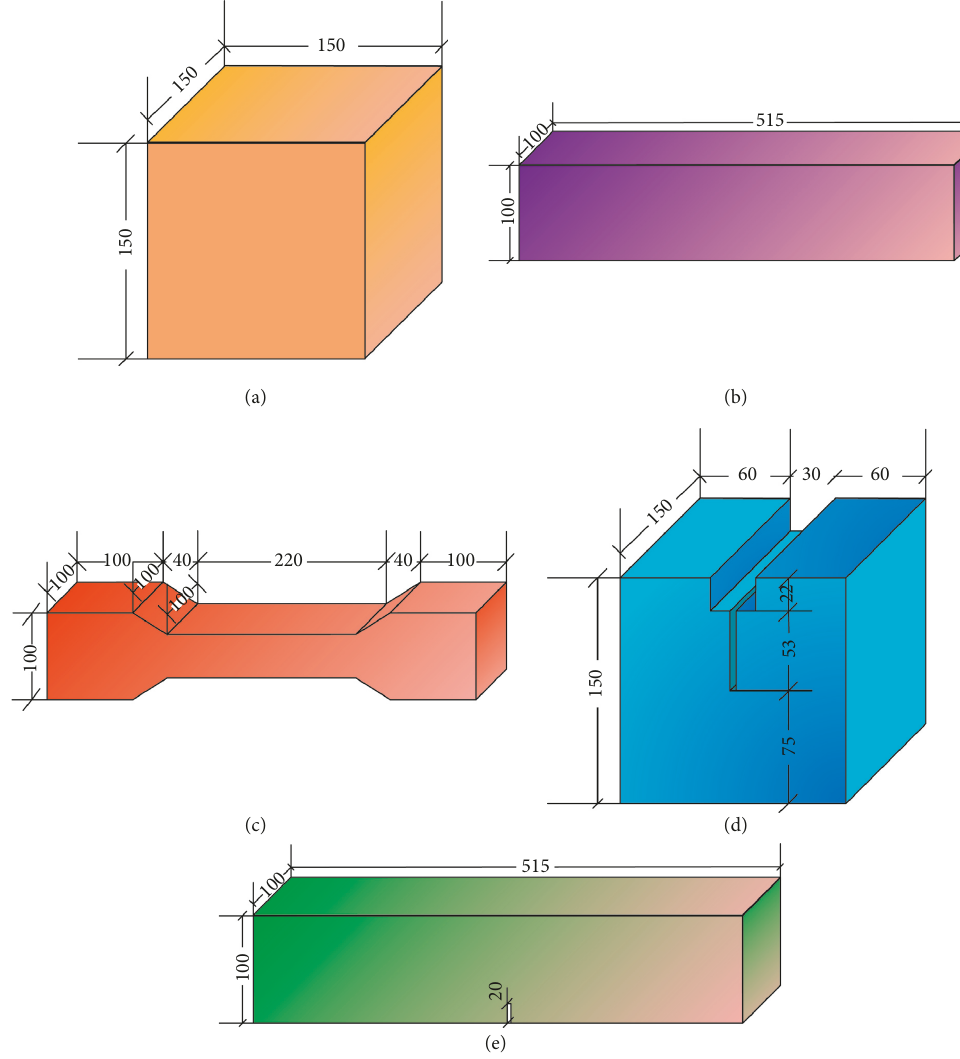
Figure 2: Shapes and sizes of specimens in different tests in millimetres: (a) compressive strength test specimen; (b) flexural strength test specimen; (c) uniaxial tensile test specimen; (d) wedged split tensile test specimen; (e) bending test